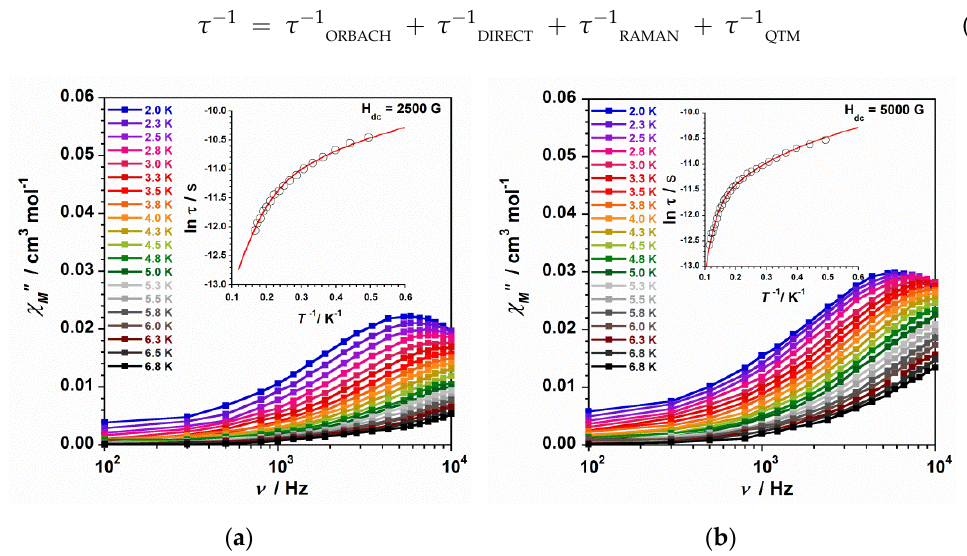
Figure 7. ( a ) Out-of-phase ac susceptibility vs. frequency plot under an external dc field of 2500 G for 2 . The inset is the ln( τ ) vs. 1/ T plot with the fit considering the contribution of two relaxation mechanisms (direct + Raman); ( b ) Out-of-phase ac susceptibility vs. frequency plot under an external dc field of 5000 G for 2 . The inset is the ln( τ ) vs. 1/ T plot with the fit considering the contribution of two relaxation mechanisms (direct +